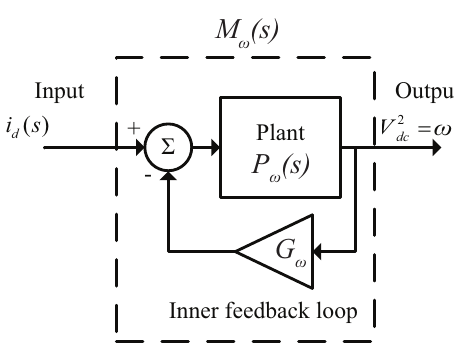
Figure 6. The inner feedback loop applied to improve the load disturbance rejection of the DC voltage